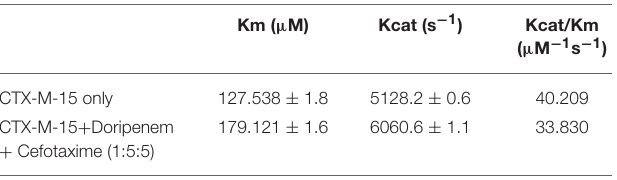
TABLE 5 | Steady-State kinetic parameters for hydrolysis activity of CTX-M-15 in presence of doripenem and